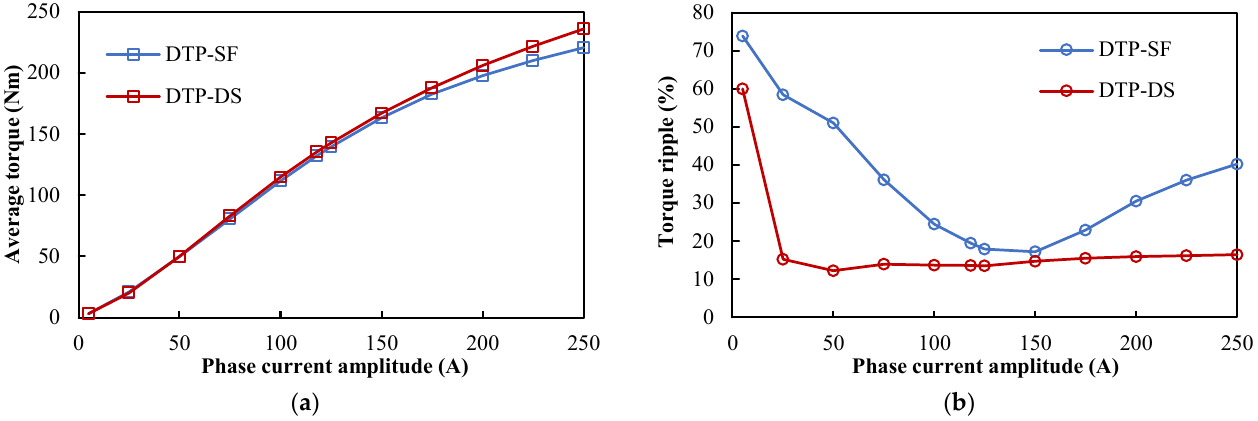
Figure 39. Torque-current amplitude characteristics of different winding configurations with the MTPA strategy under the three-phase OC condition considering over-loading: ( a ) average torque; ( b ) torque ripple.